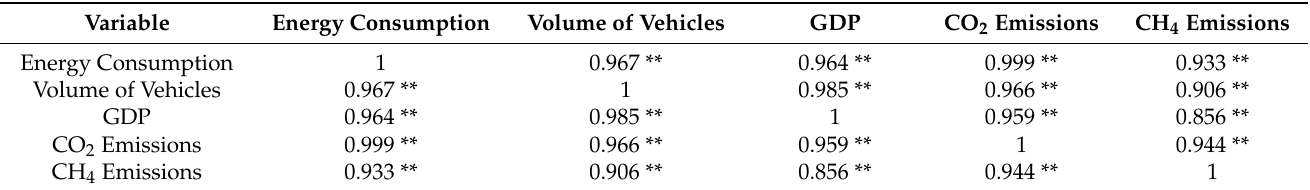
Table 4. Correlation coefficients of inputs and outputs in 2017. Source: Authors’